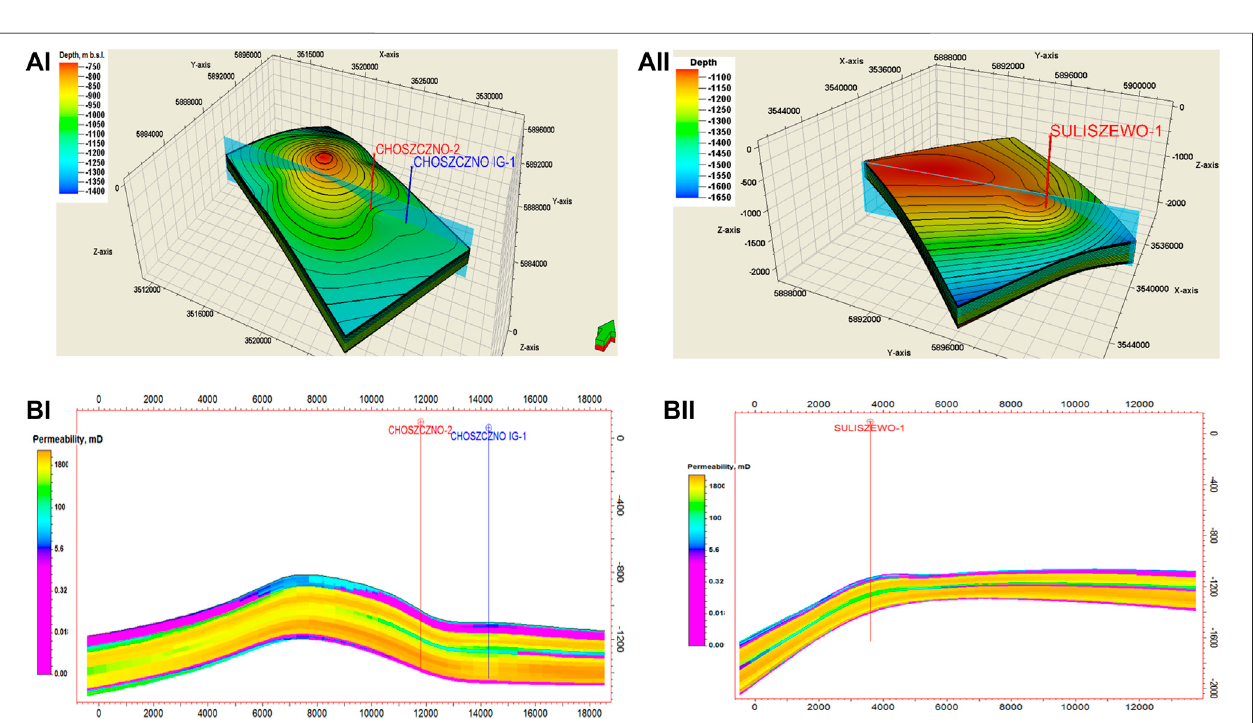
FIGURE3|(A) Locationoftheinjectionwellinthe (I) Choszcznoand (II) Suliszewostructure; (B) cross-sectionthroughthestructureintheareaoftheChoszczno- 2 and Suliszewo injection wells, respectively.